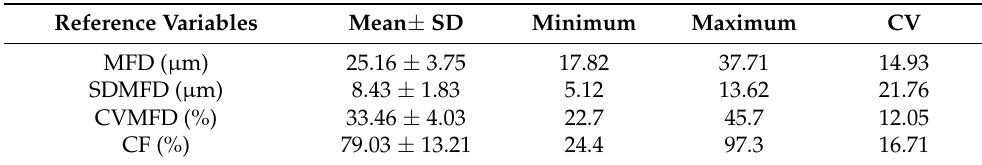
Table 1. Reference analysis of llama samples obtained with OFDA 2000.